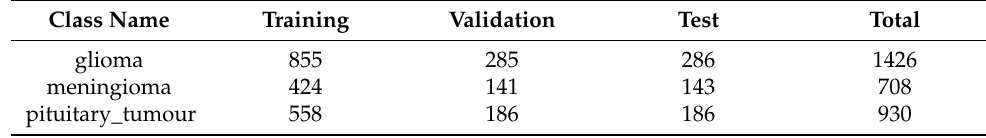
Table 2. The distribution of Brain tumour dataset.